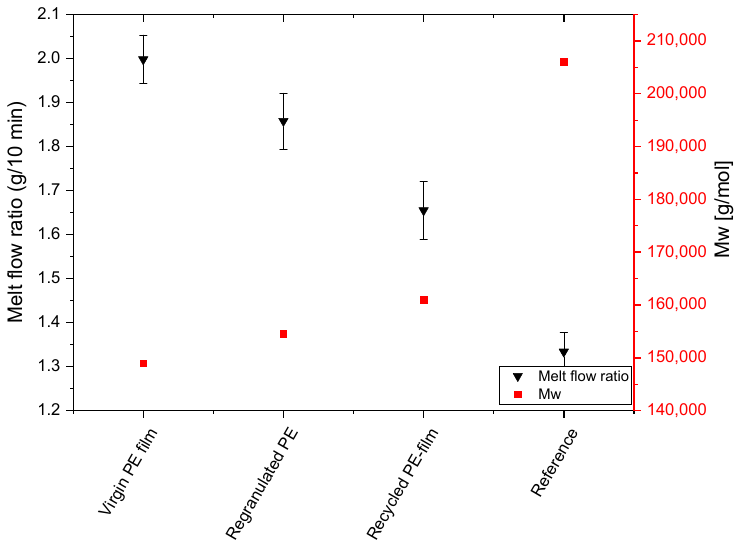
Figure 14. Change in MFI and molecular weight after regranulation/cast film extrusion of the delaminated LDPE compared with the commercial LDPE film used to produce the laminate (virgin LDPE film) and the regranulated virgin film (reference).